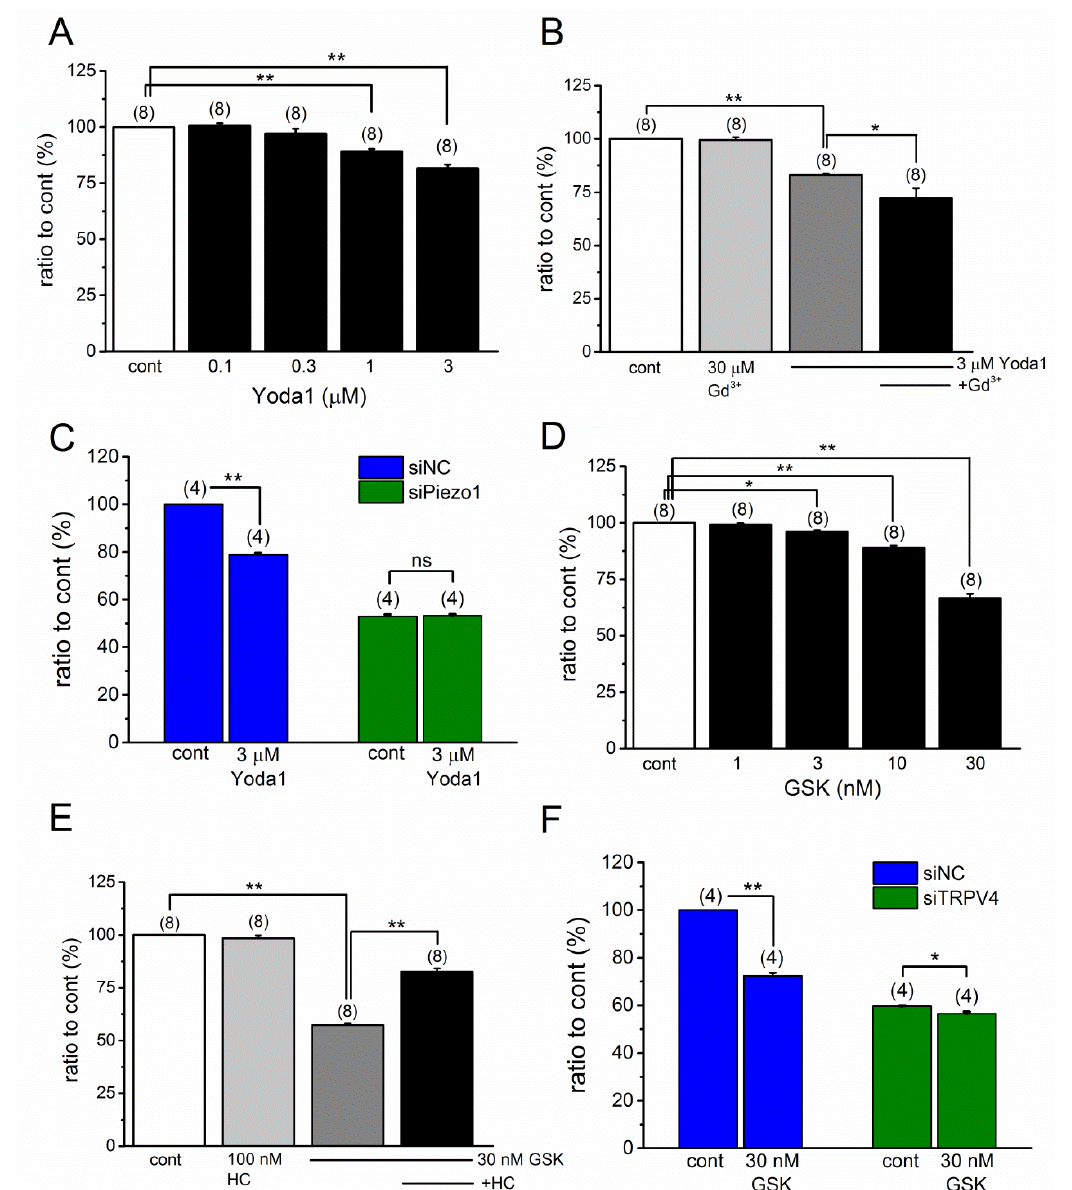
Figure 7. MC3T3-E1 proliferation with, or without, Yoda1 and GSK. ( A – F ) MC3T3-E1 cells were treated with Yoda1 ( A ) or GSK ( D ) for 24 h at a concentration ranging between 0.01 to 3 µ M, and 1 to 30 nM, respectively, and cell proliferation at each concentration was measured with WST-1 assay. ( B , E ) Yoda1 (3 µ M) or GSK (30 nM) was applied to MC3T3-E1 cells in the presence, and absence of, 30 µ M Gd 3 + (B), or 100 nM HC (E), respectively, and the cell proliferation under each experimental condition was summarized. ( C , F ) Yoda1 (3 µ M) or GSK (30 nM) was applied to MC3T3-E1 cells transfected with siPiezo1 and siNC ( C ) or with siTRPV4, and siNC ( F ), respectively, and cell proliferation under each experimental condition was summarized. MC3T3-E1 cells were treated with siNC, siPiezo1, and siTRPV4 for 96 h. Pooled data were averaged and expressed as mean ± SEM. Statistical significance was established using Student’s t -test and Tukey-Kramer test. * p < 0.05 and ** p < 0.01, when compared to each corresponding control group. ‘ns’ indicates no significance. The numbers in parentheses indicate the number of independent experiments.